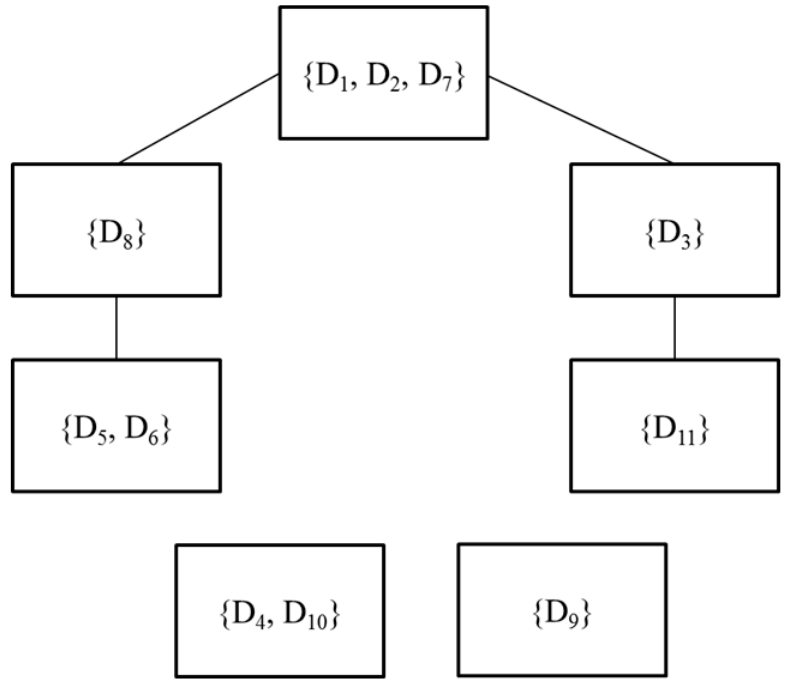
Figure 2. Relations of opinions existing in D.